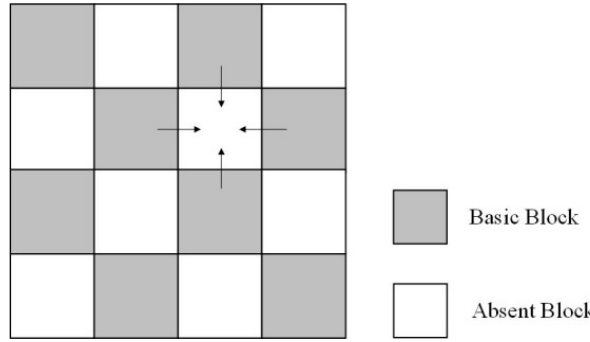
Figure 2. The block classification model.